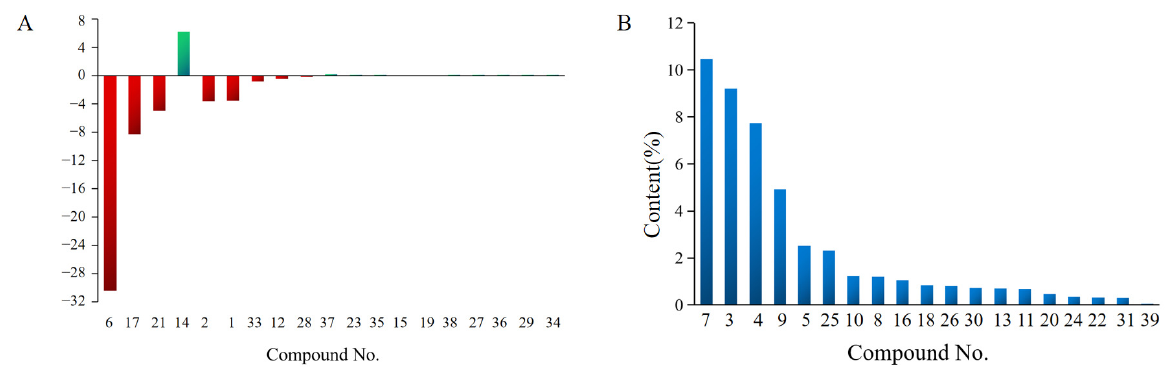
Figure 4. Increase (green) and decrease (red) in common volatile compounds after rancidity ( A ). The content of unique volatile compounds in rancid samples ( B ).